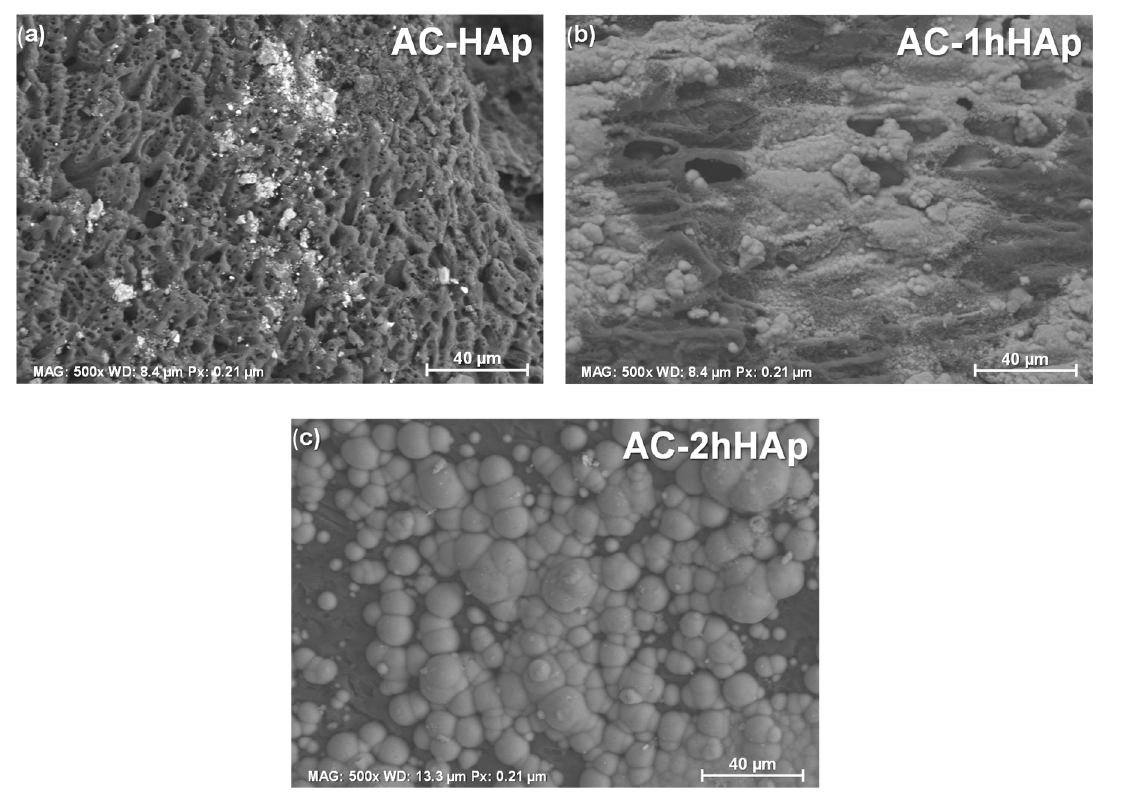
Figure 6. SEM microscopies of the HAp-modified carbon samples; ( a ) AC-Hap, ( b ) AC-1hHAp, and ( c ) AC-2hHAp.